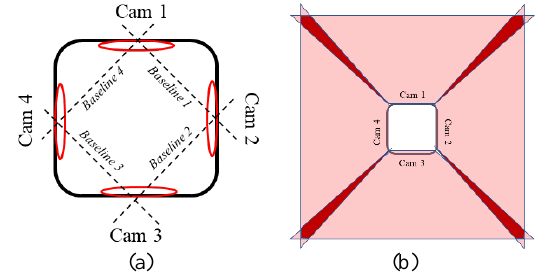
Figure 1. Multi camera rig concept: (a) corresponding between each camera (b) horizontal FoV (bright red) and overlapping between each camera (dark